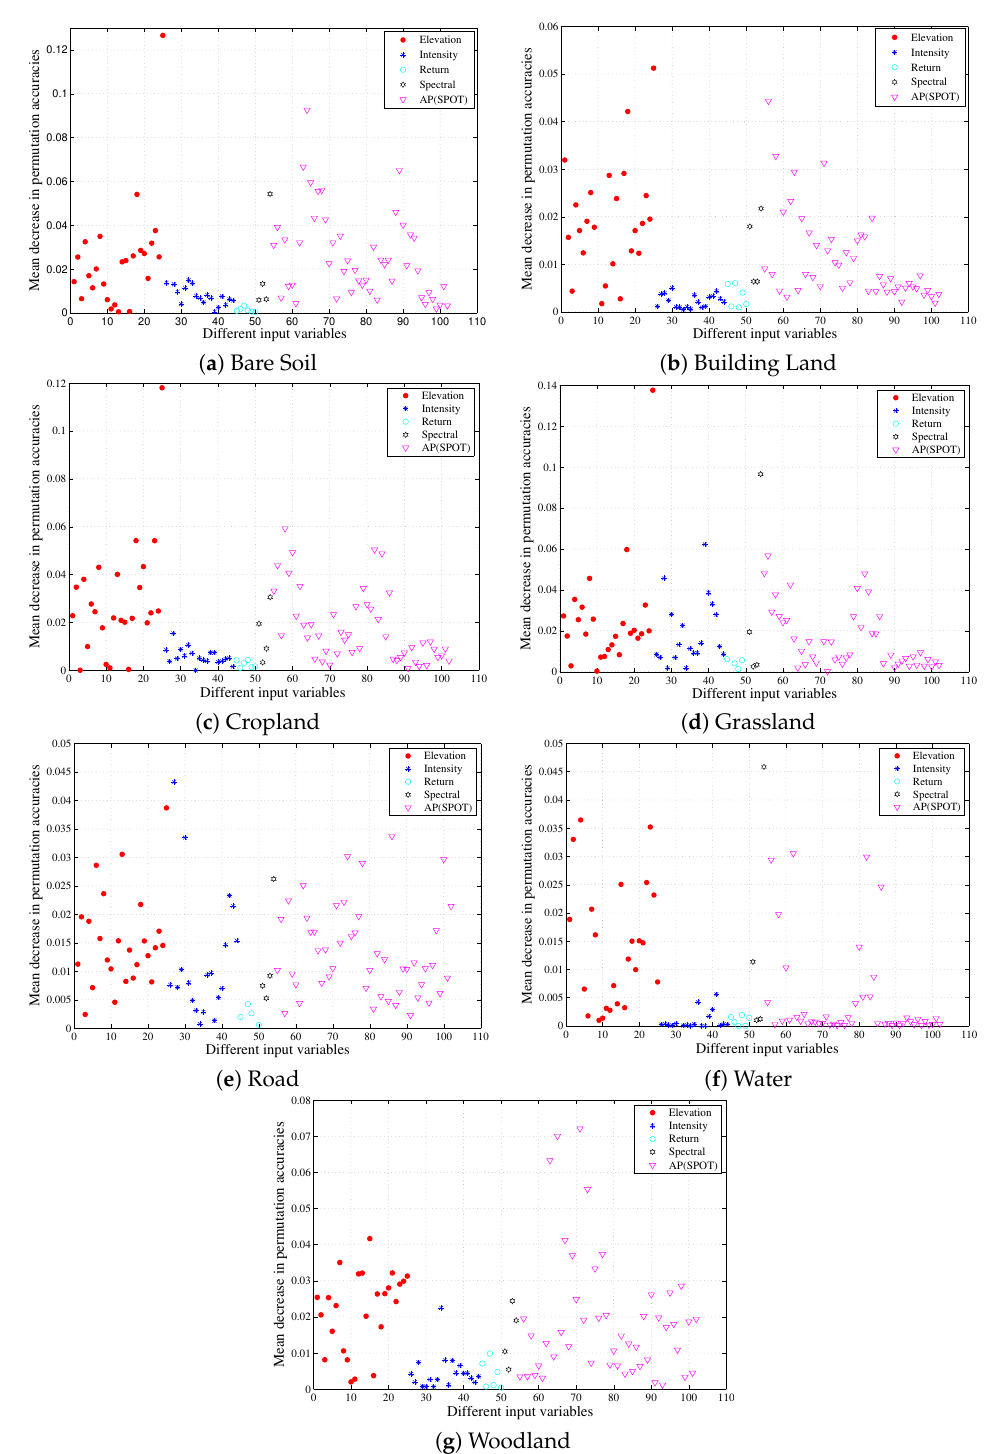
Figure 6. Feature importance per class by using mean decrease permutation